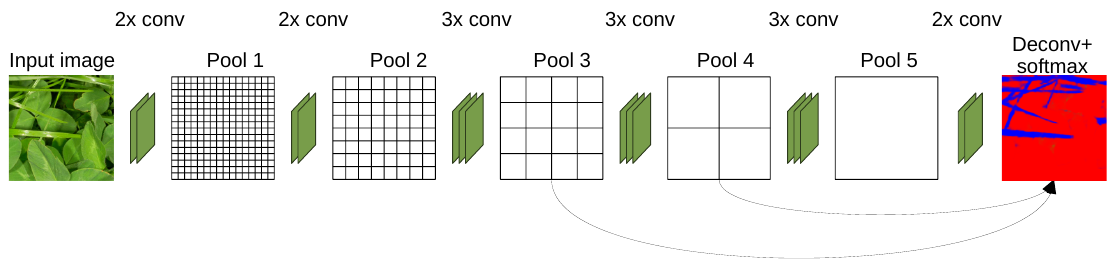
Figure 7. The fully convolutional network with a output stride of 8 (FCN-8s) architecture. The network consists of 15 convolutional layers and 5 max pooling layers. The outputs from pooling layers three and four were routed through deconvolution layers to help restore smaller details in the segmented images. (This figure is redrawn from Long et al.